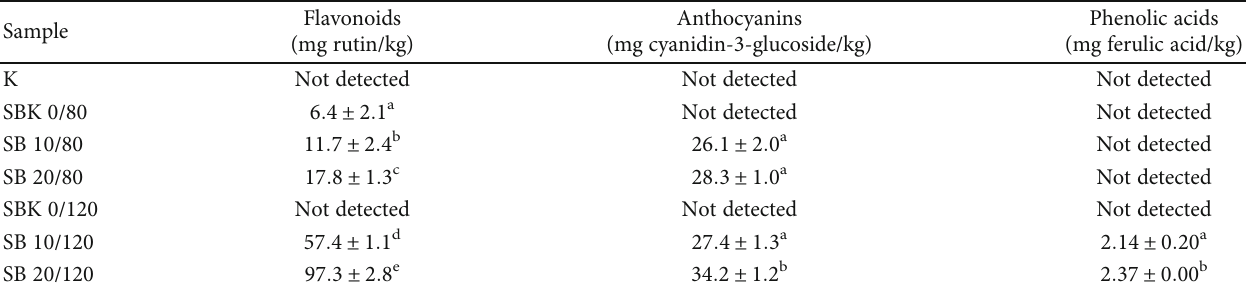
Table 4: Contents of fl avonoids, anthocyanins, and phenolic acids in the examined bread samples (in dry matter). Sample